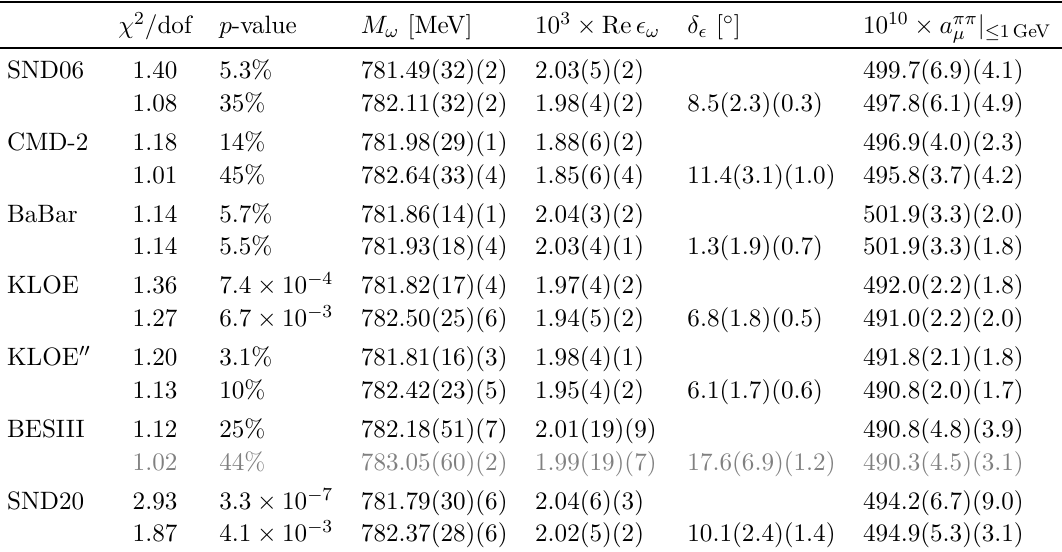
Table 1 . Comparison of fits to single experiments with and without a phase δ (cid:15) in (cid:15) ω . Note that BESIII has only a few data points in the interference region and hence is not able to put a strong constraint on δ (cid:15) (the corresponding line is indicated in gray). The first error is the fit uncertainty, p inflated by χ 2 / dof , the second error is the combination of all systematic uncertainties.